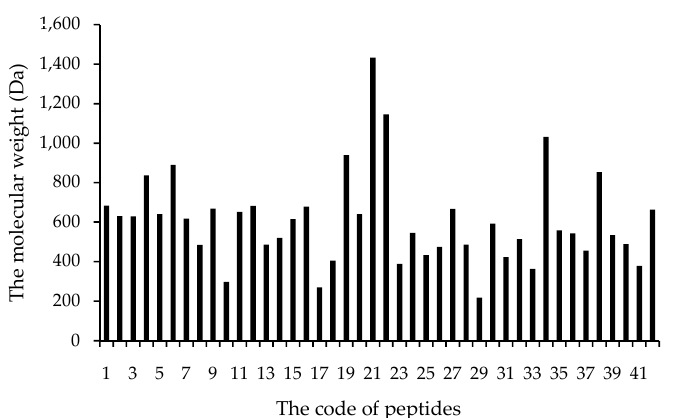
Figure 2. The molecular weight of 42 antioxidant peptides in Table 1.